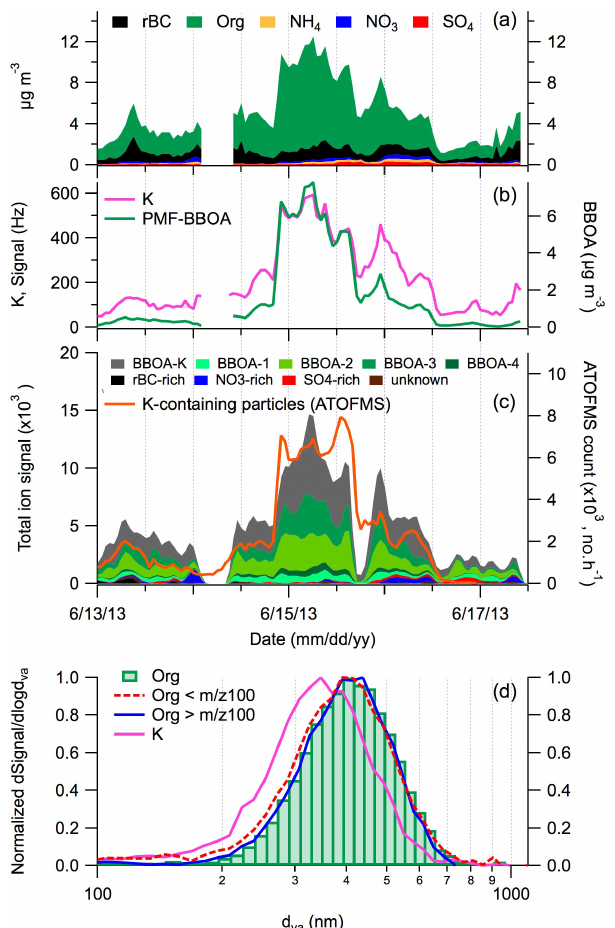
Figure 1. Time series of (a) rBC and NR-PM rBC (Org, SO 4 , NO 3 , NH 4 ), (b) K + and PMF-BBOA factor measured by the LS- SP-AMS, (c) number of K-containing particles measured by the ATOFMS (right axis) and total ion signal of all particle classes iden- tified by cluster analysis of LS-SP-AMS data (left axis). (d) Size distributions of K + and Org associated with rBC measured by the